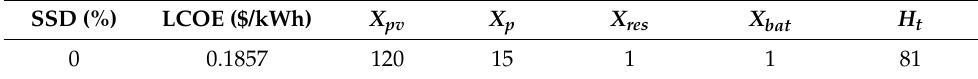
Table 4. Optimized parameters of the system-based battery energy storage.